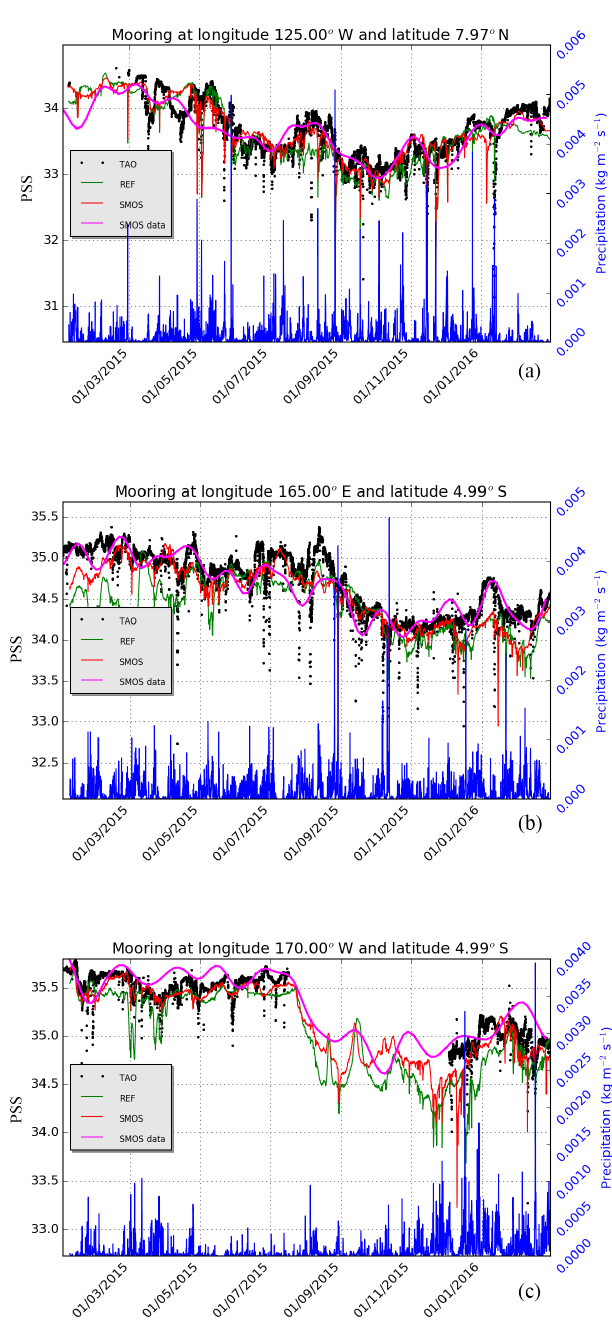
Figure 15. Time evolution of the hourly TAO observed salinity (black), the hourly model REF (green), SMOSexp (red) simulations and the assimilated SMOS data (magenta) at three different TAO moorings locations: cold tongue (a) (7.97 ◦ N, 125 ◦ W), warm pool (b) (4.99 ◦ S, 165 ◦ E) and (c) salt front (4.99 ◦ S, 170 ◦ W) from Jan- uary 2015 to March 2016. The precipitation rate (blue line) coming from the atmospheric ECMWF forcing is